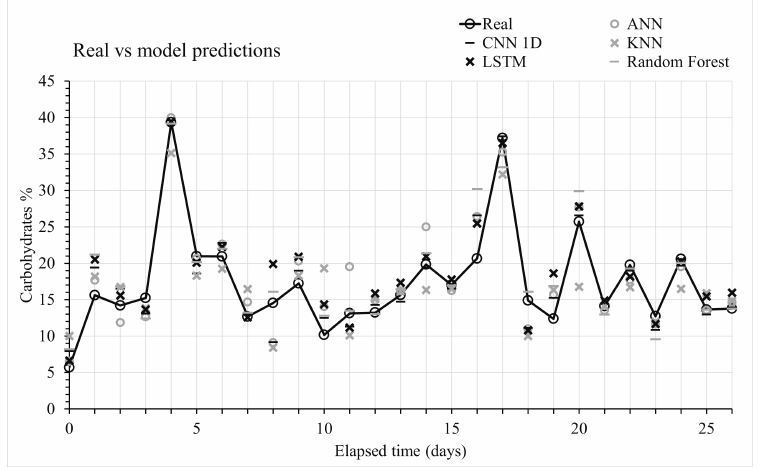
Figure 7. Comparison of the five artificial intelligence models vs. the real value of % carbohydrates.